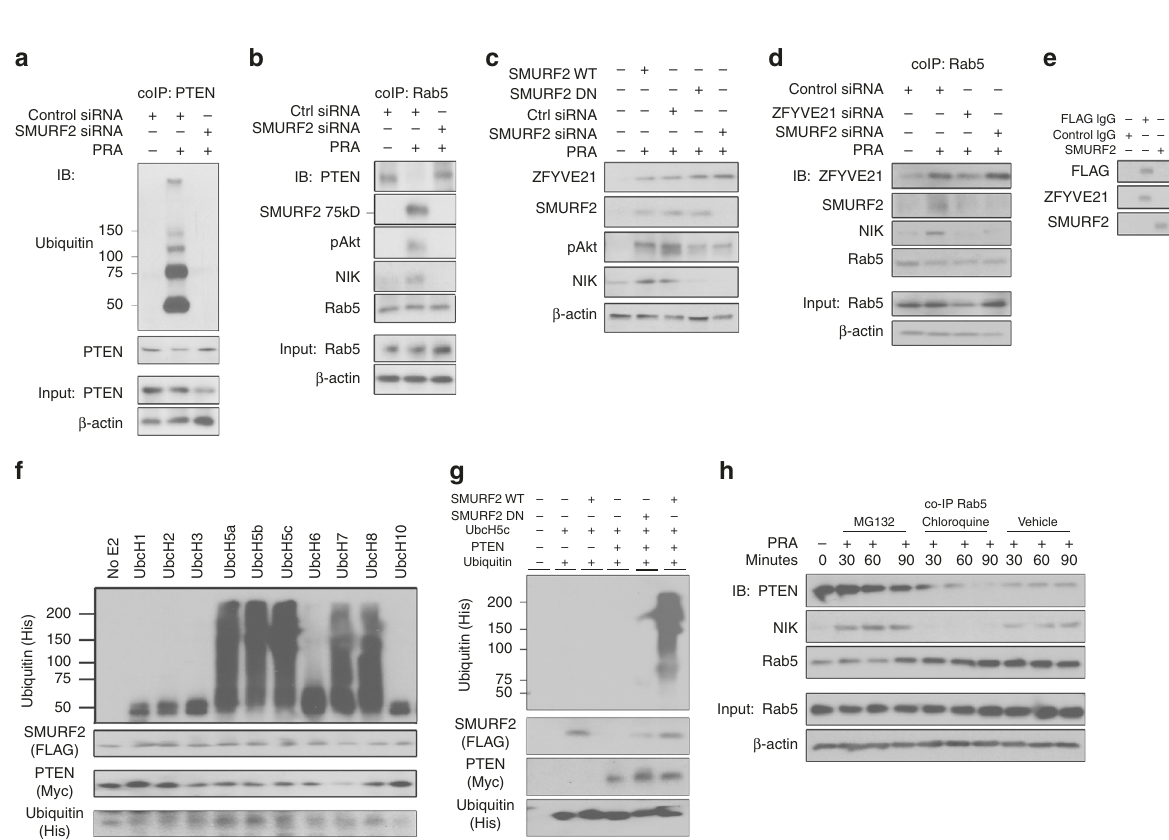
Fig. 3 SMURF2-dependent degradation of vesicular PTEN. PTEN co-immunoprecipitations (co-IPs) were performed on human umbilical vein endothelial cells (HUVECs) treated for 30 min with panel reactive antibody (PRA) sera and blotted as indicated ( a ). Rab5 co-IPs were performed on PRA-treated HUVECs transfected with control or SMURF2 siRNA ( b ). Western blot analysis of whole-cell lysates of HUVECs transiently transfected with SMURF2 WT, SMURF2 DN, control siRNA, and SMURF2 siRNA ( c ). HUVECs transfected with control, SMURF2, or ZFYVE21 siRNA were treated with PRA and Rab5 co- IPs were performed ( d ). Recombinant FLAG-tagged ZFYVE21 (1 μ g) and/or recombinant SMURF2 (1 μ g) protein was incubated for 30 min at room temperature and analyzed by western blot ( e ). In vitro kinase assays were performed using various E2 ubiquitin ligases with SMURF2 protein (1 μ g) as the E3 ubiquitin ligase and PTEN (1 μ g) as substrate ( f ). In vitro kinase assays were performed using isolated SMURF2 WT or SMURF2 DN as E3 ubiquitin ligases, UbcH5c as the E2 ubiquitin ligase, and PTEN as substrate as indicated ( g ). HUVECs were pretreated with MG132 for 4 h or chloroquine for 30 min prior to PRA treatment at the indicated times prior to Rab5 co-IP and western blot analysis ( h ). Western blot analyses were repeated two to four times. Confocal microscopic studies analyzed ≥ 4 cells per group and was repeated three times. In vitro kinase assays were repeated twice. Representative data implanting HUVECs transduced with Rab5 WT or Rab5 DN recapitulate our fi ndings in vivo, we utilized a previously constructs, control or ZFYVE21 shRNA, or control or SMURF2 shRNA. Twenty-four hours prior to harvest, mice were vessels in SCID/bg mice. HUVECs were suspended in intravenously injected with PRA sera. Upon harvest, microvessels from all groups showed staining for C4d, indicative of comple- ment activation (Supplementary Fig. 3a, top). The PRA-treated Rab5 WT EC but not Rab5 DN EC upregulated ZFYVE21 (Supplementary Fig. 3a, bottom), HUVECs containing control but not ZFYVE21 shRNA upregulated SMURF2 (Supplementary